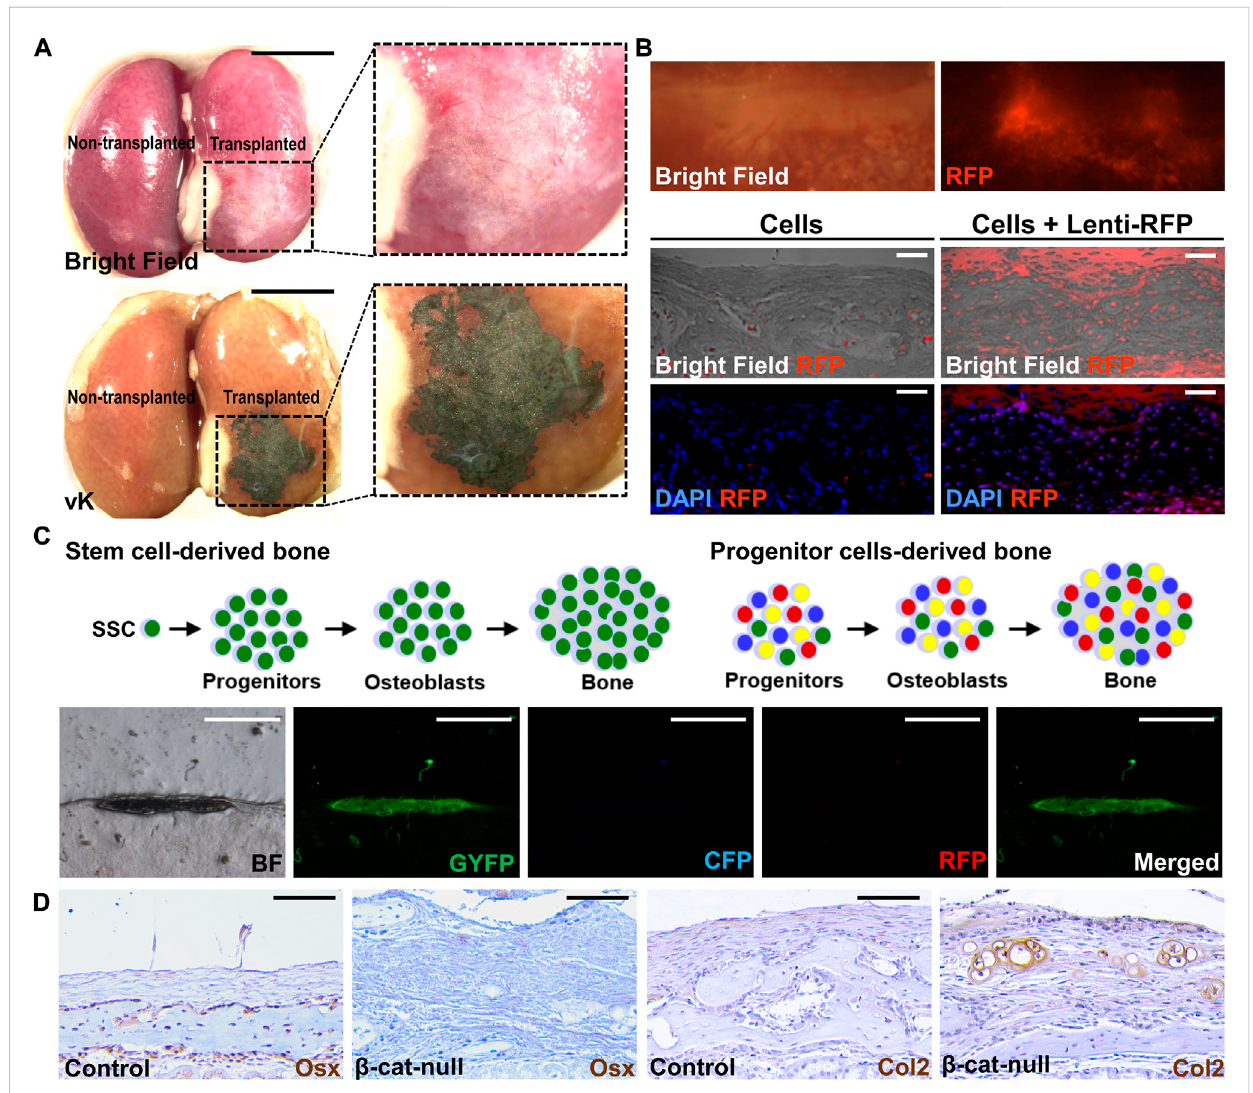
FIGURE 1 Post-transplantationanalysesoftissuegeneration. (A) Wholemountanalysisofthekidneytransplanted(right)andnon-transplanted(left)by10 4 cells isolated from C57/BL6 mouse sutures in bright fi eld (top) and von Kossa (vK) staining (bottom). Enlargements of the inset indicate bone formation underneath the kidney capsule. (B) Wholemount analysis of the kidney transplanted by suture cells infected by lentivirus expressing the RFP reporter (Lenti-RFP). Analysis of renal sections containing the transplant of 5 × 10 4 suture cells with or without infection of Lenti-RFP. (C) Diagrams illustrate the use of the confetti mouse allele to examine potential mechanisms for bone formation by the skeletal stem cell (SSC) or progenitor cells upon renal capsule transplantation. The representativeimagesshow thebone isformedby single-color cells indicating its generation by asingle suture stem cell via the clonal expansion mechanism. (D) Examining lineage speci fi cation of skeletal stem cells by transplantation. Analysis of the renal capsule transplanted by5×10 4 control (A,C) or β -cat-null (B,C) suturecellsbyimmunostainingofOsterix(Osx)andtype2collagen(Col2).Noteskeletalstemcellsresiding in the suture (SuSCs) are developmentally programmed to become osteoblasts positive for Osx but the loss of β -catenin alters their fate to form Col2 positive chondrocytes Scale bars, 5 mm (A) ; 200 μ m (B) ; 400 μ m (C) ; 50 μ m (D)